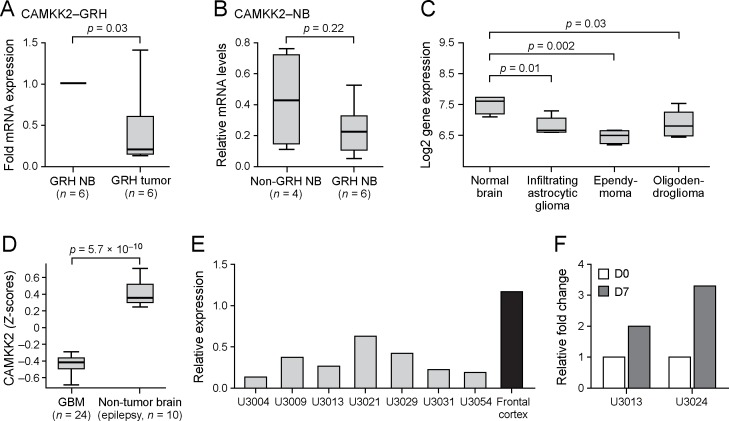
Expression changes of CAMKK2 in canine and human brain tumors.Distributions of expression values in the different groups are depicted as box-and-whisker-plots, with the median of expression represented by horizontal lines inside each box, lower and upper box borders indicating 25th and 75th percentiles, respectively, and regions between whiskers including all non-outlier values. (A) Quantitative RT-PCR comparing matched normal brain (nominally 1.0) to tumor tissue in dogs with the glioma risk haplotype (GRH) and (B) comparing normal cerebrum from GRH and non GRH tissue. Significantly decreased CAMKK2 mRNA expression is seen in GRH tumors. (C) Human expression data was obtained from a study by Liu and colleagues [40]. Comparing to normal brain (n = 4), mRNA expression level of CAMKK2 is significantly lower in astrocytic glioma (n = 5), ependymoma (n = 4), and oligodendroglioma (n = 5). (D) Another set of human expression data was obtained from the TCGA Research Network and shows a significant lower expression in GBM patients (n = 24) compared to epileptic normal brain (n = 10). (E) Quantification of Western blot of CAMKK2 in human patient-derived GBM cell lines and normal adult brain lysate. Comparing to adult brain, GBM cell lines exhibit a lower level of CAMKK2. (F) When induced to differentiation with serum, CAMKK2 mRNA levels increase in patient-derived GBM cells between day 0 (D0) and day 7 (D7). This experiment has been repeated twice.